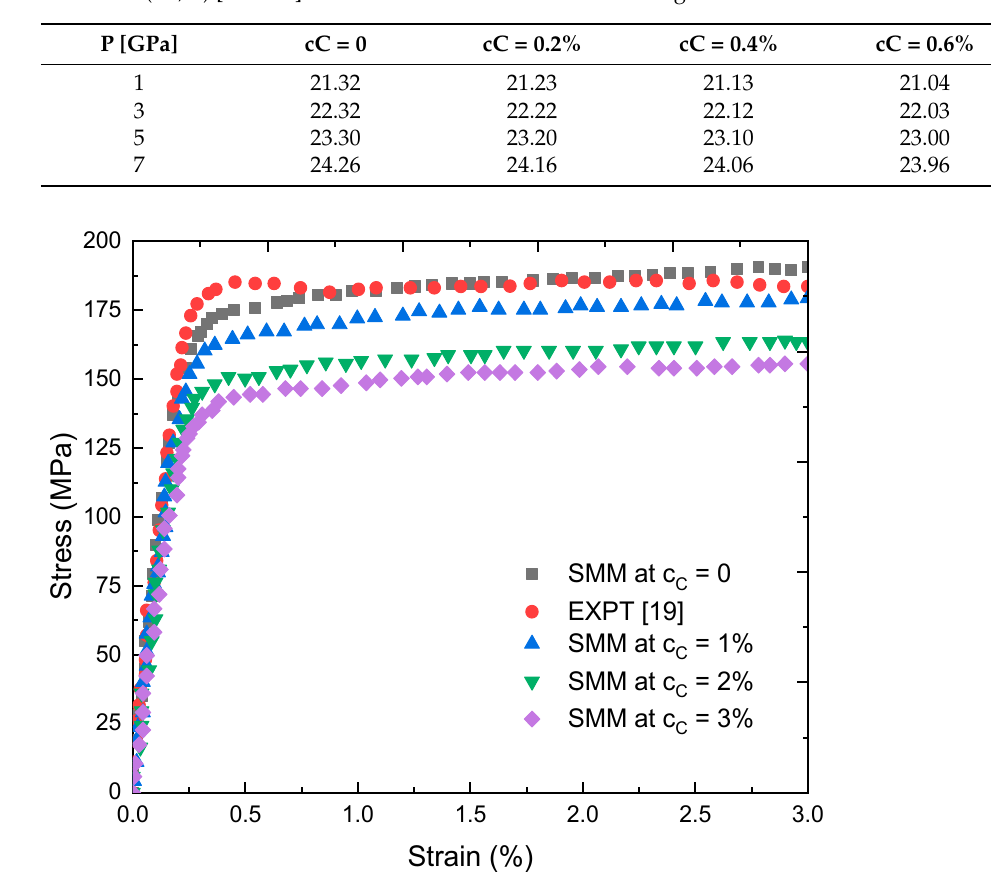
Figure 6. Stress-strain relationship at T = 325 K obtained using the SMM with FeC alloy and from EXPT [19] with Fe.